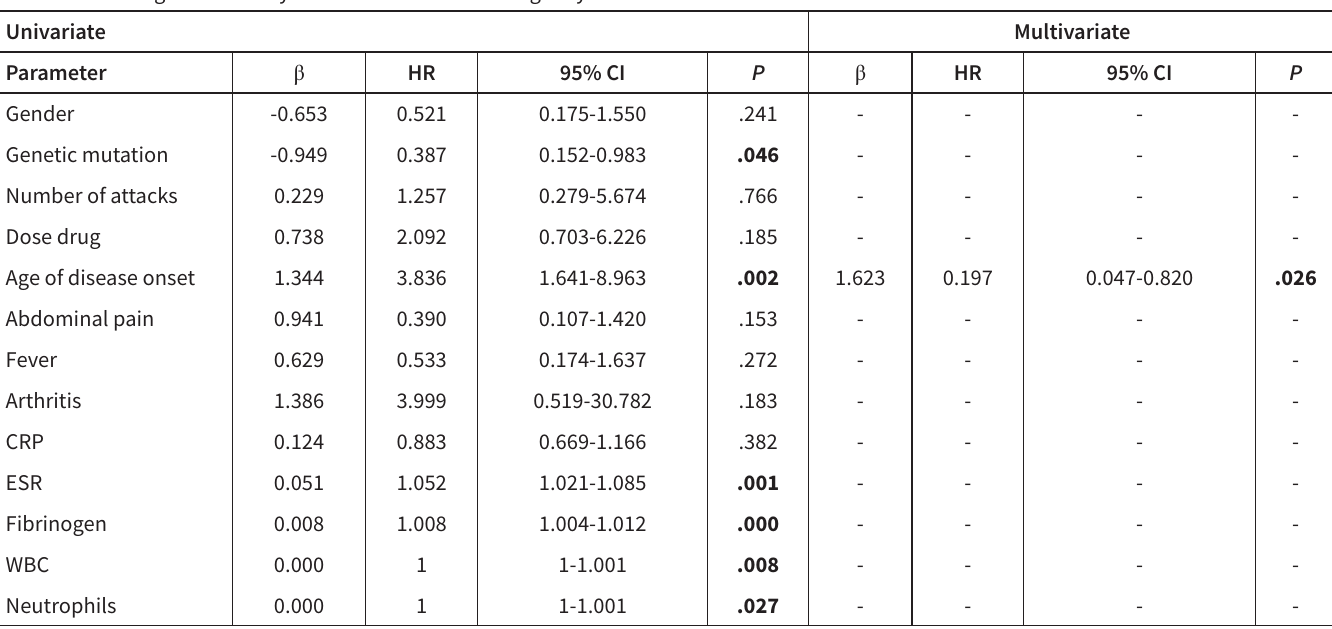
Table 4. Cox Regression Analysis of Risk Factors Affecting Amyloidosis in FMF Patients